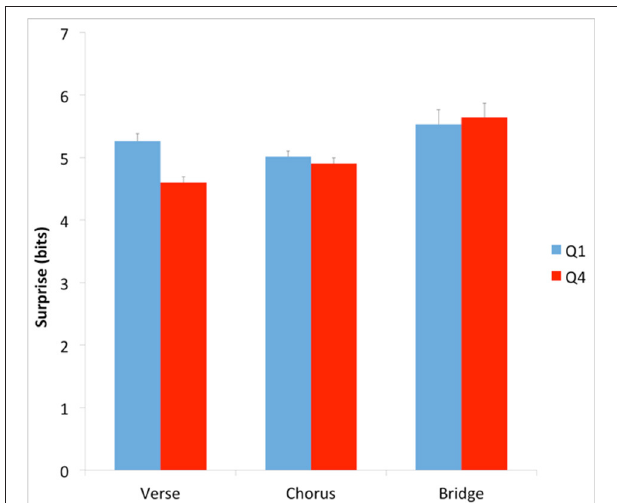
bridges. Error bars are standard errors. Verses, but not choruses and bridges, account for the difference in surprise between Q1 and